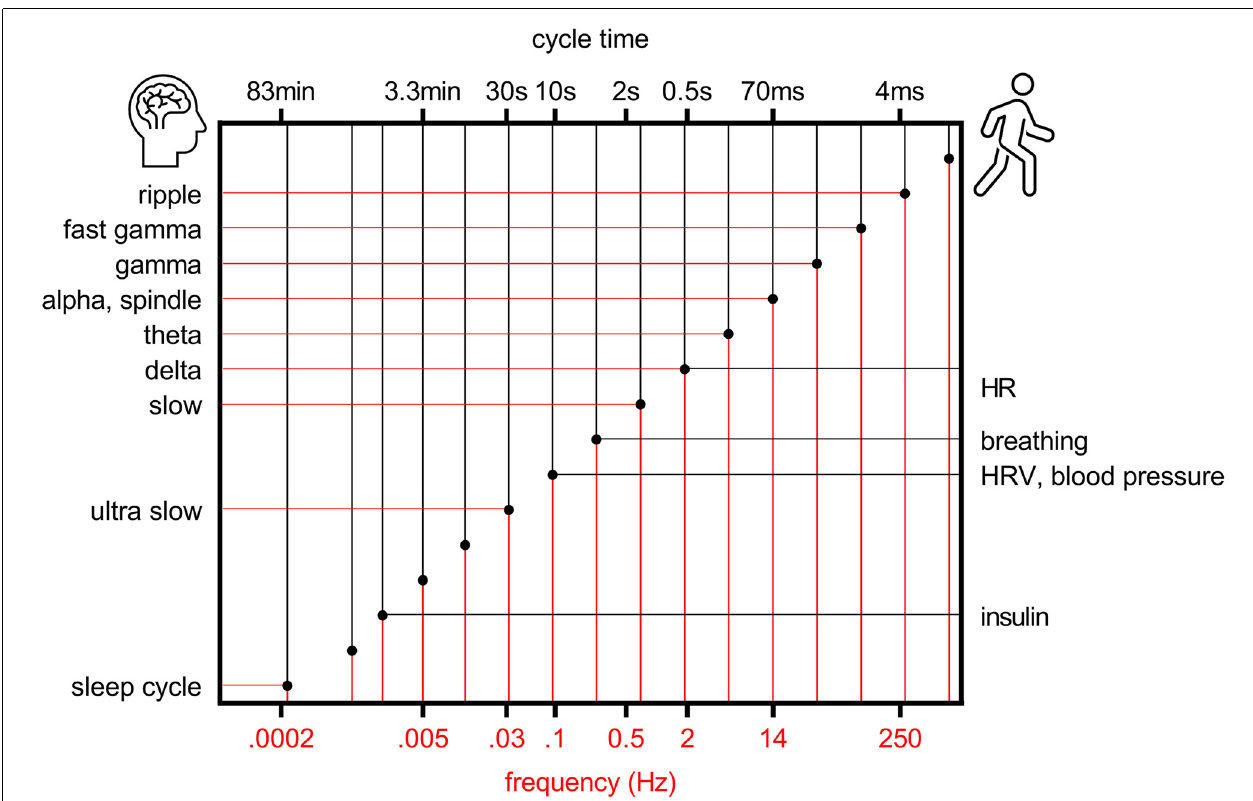
FIGURE 1 | Rhythms of the brain and body follow a logarithmic scale. Organization of brain (left y-axis) and bodily (right y-axis) rhythms on a logarithmic scale, modified from Penttonen and Buzsaki (2003). HR, heart rate; HRV, heart rate